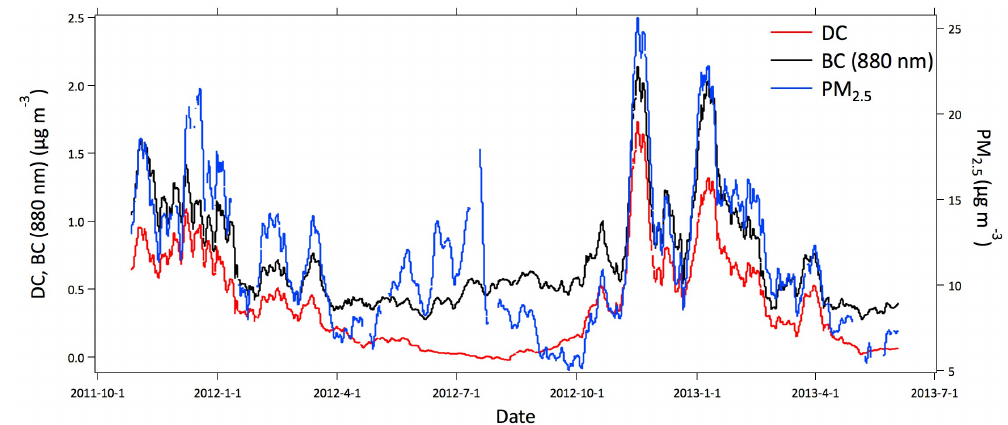
Figure 3. Two-week moving average DC (i.e., BC (370nm) − BC (880nm)), BC (880nm), and PM 2 . 5 values measured at the Rutland site from October 2011 to June 2013.